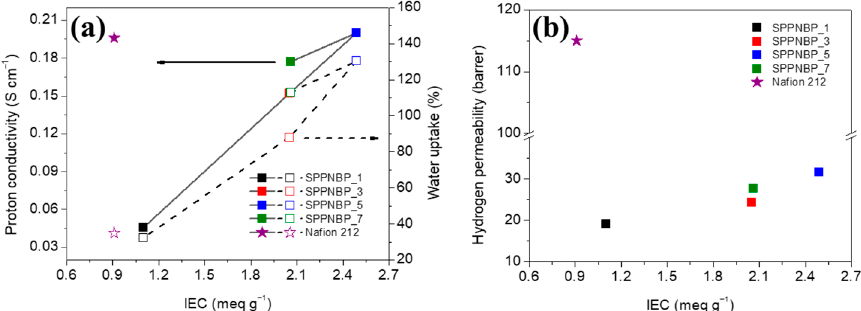
Figure 4. ( a ) The relation between the proton conductivities and the water uptake values of SPPNBP membranes and Na fi on 212 membranes depending on IEC at 80 °C. ( b ) Hydrogen permeability of the membranes at 80 °C.